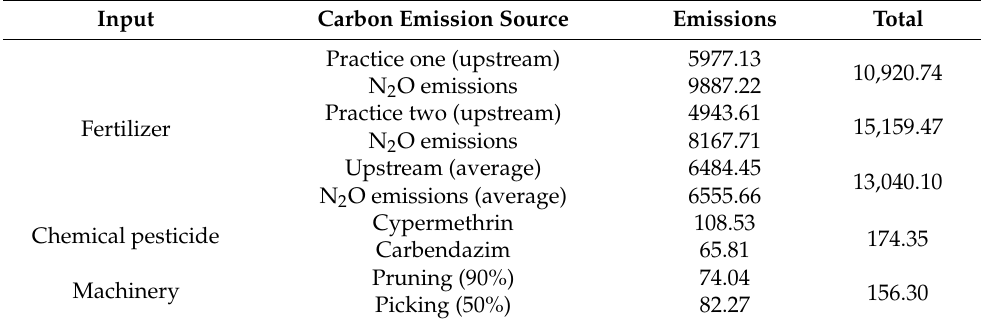
Table 7. Composition of carbon emissions during the cultivation stage (kg CO 2 eq ha − 1 ).